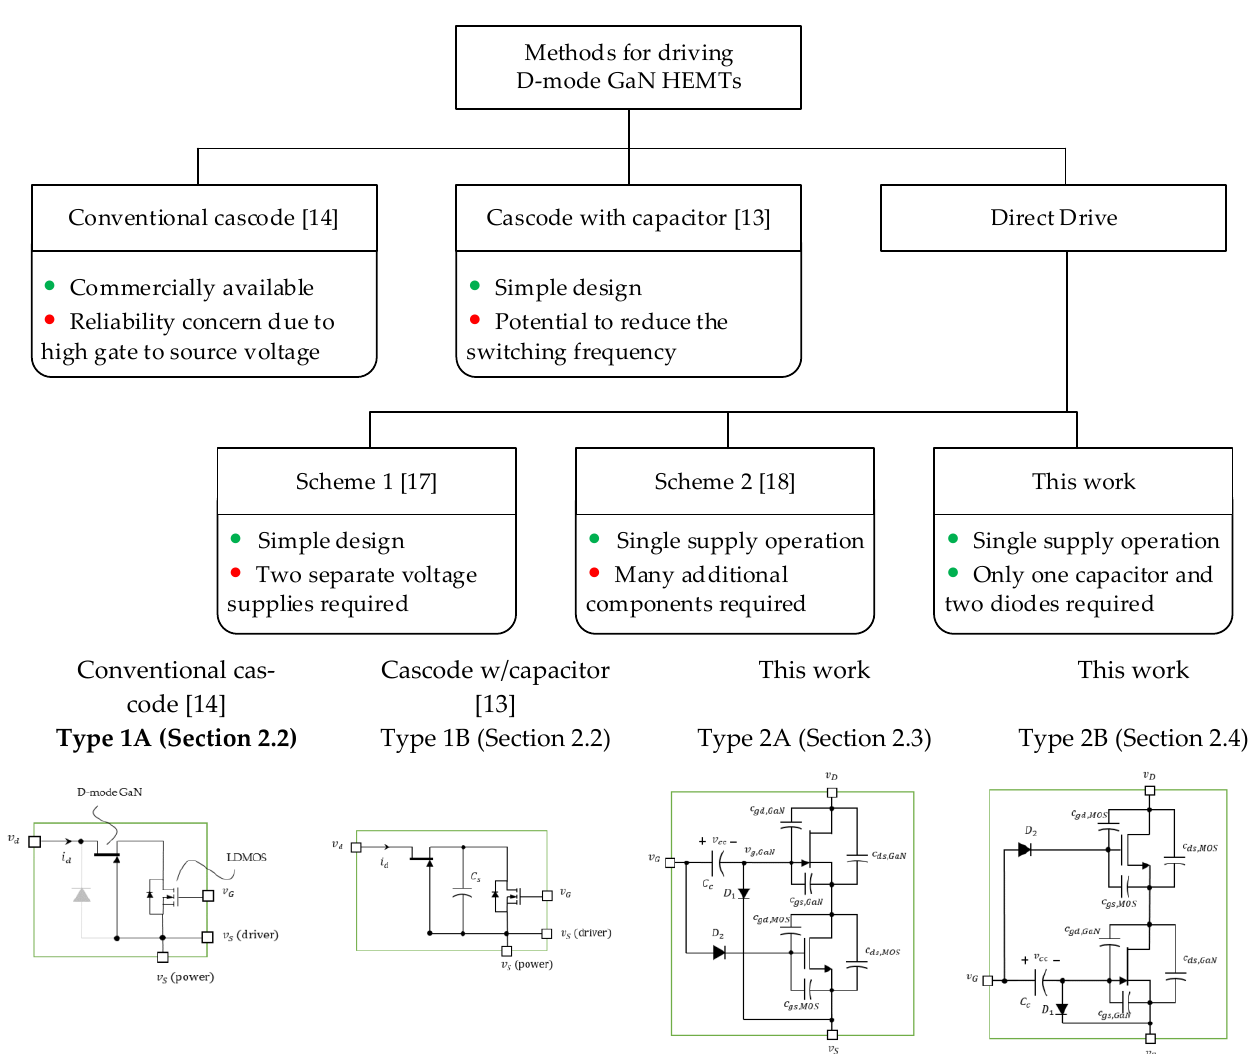
Figure 1. Comparison of the proposed scheme with the existing schemes [13, 14].